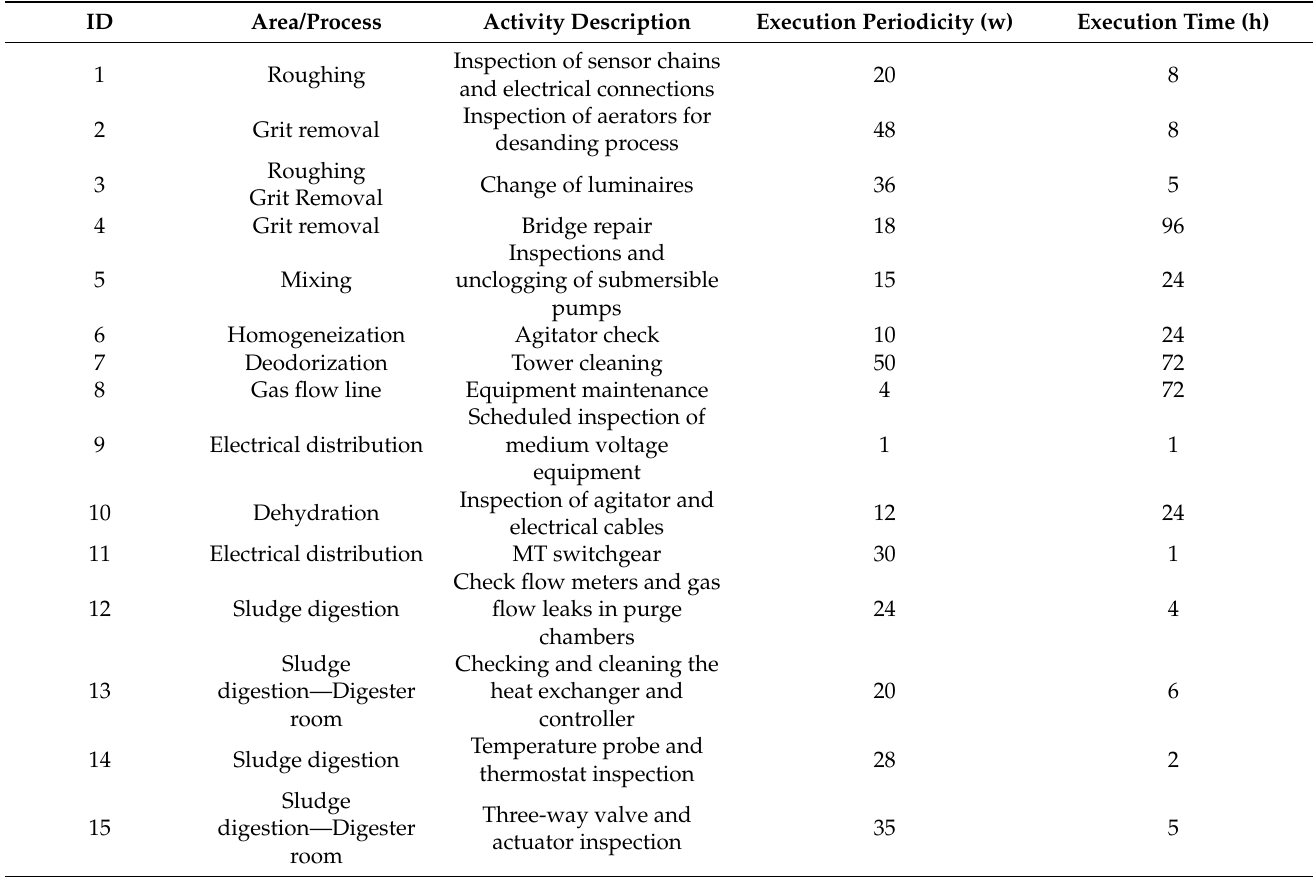
Figure 2. Anaerobic digestion process for the case study. Table 1. Preventive maintenance plan for highly critical and hazardous activities. Case